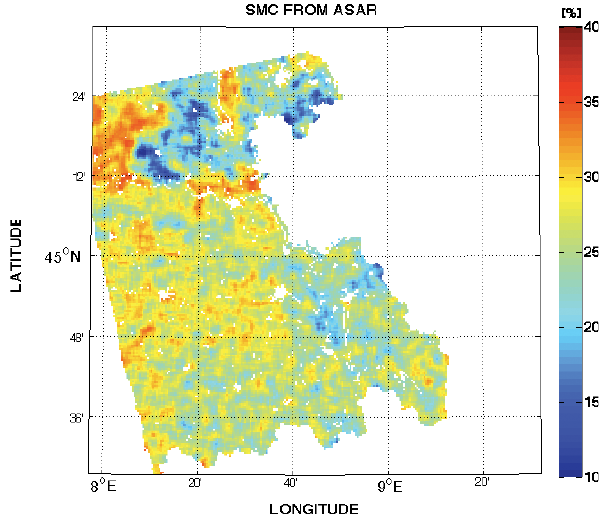
Fig. 4. Top layer SMC (%) retrieved from ASAR on 24 April, 20:53UTC and interpolated to MM5 inner domain grid points. White areas are those not observed by ASAR or not included in the Tanaro basin or flagged because the soil was not bare or scarcely